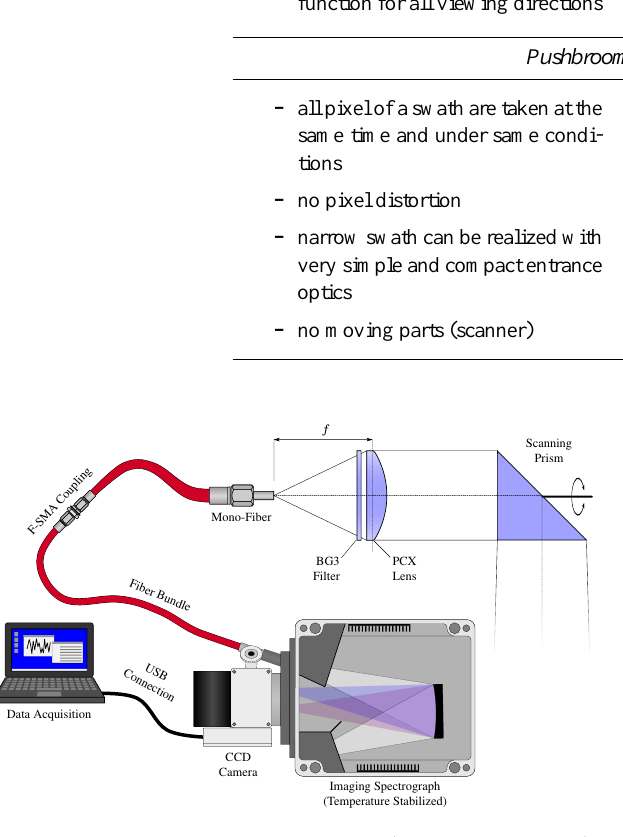
Figure 3. Setup of HAIDI’s nadir scanner (whiskbroom scanner). A sweeping prism guides the light from different viewing directions to the telescope of the system. From there the light passes through a fiber optic cable to the spectrograph. Hardware control and data acquisition is done by a computer which is connected via